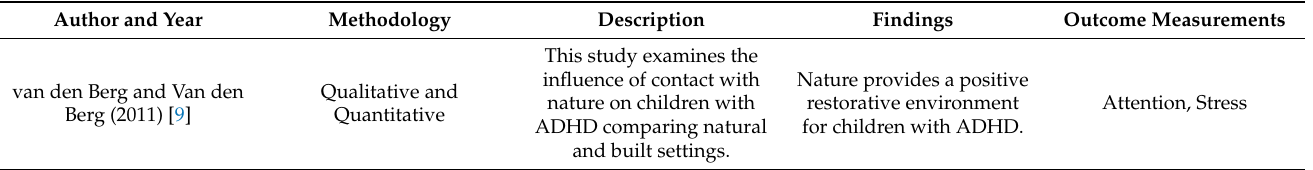
Table 1. Analysis of Literature Related to Children’s Restorative